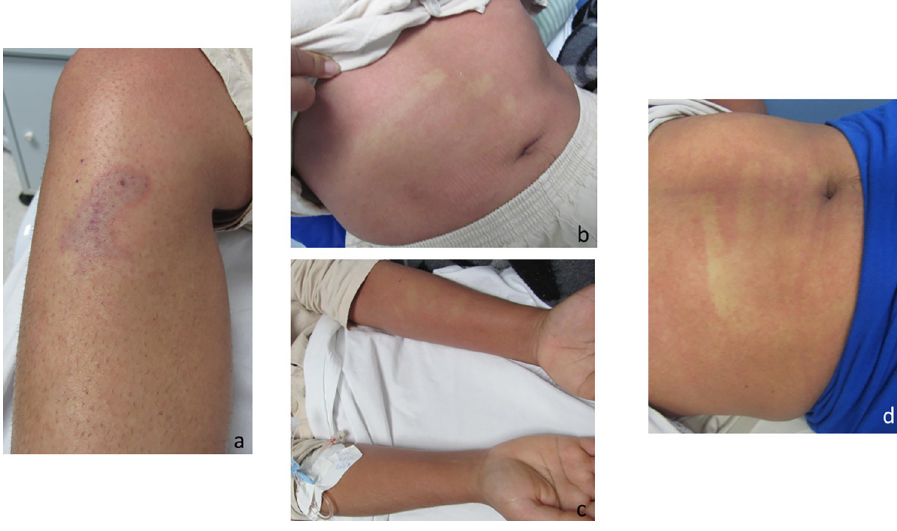
Fig 8. Evolution of a cutaneous lesion after a Loxosceles sp. bite. Marbled macula at the bite site (a), rash on the forearm (b), and rash on the abdomen (c), 4 days after the bite. (d) Persistence of the rash on the abdomen at 7 days after the